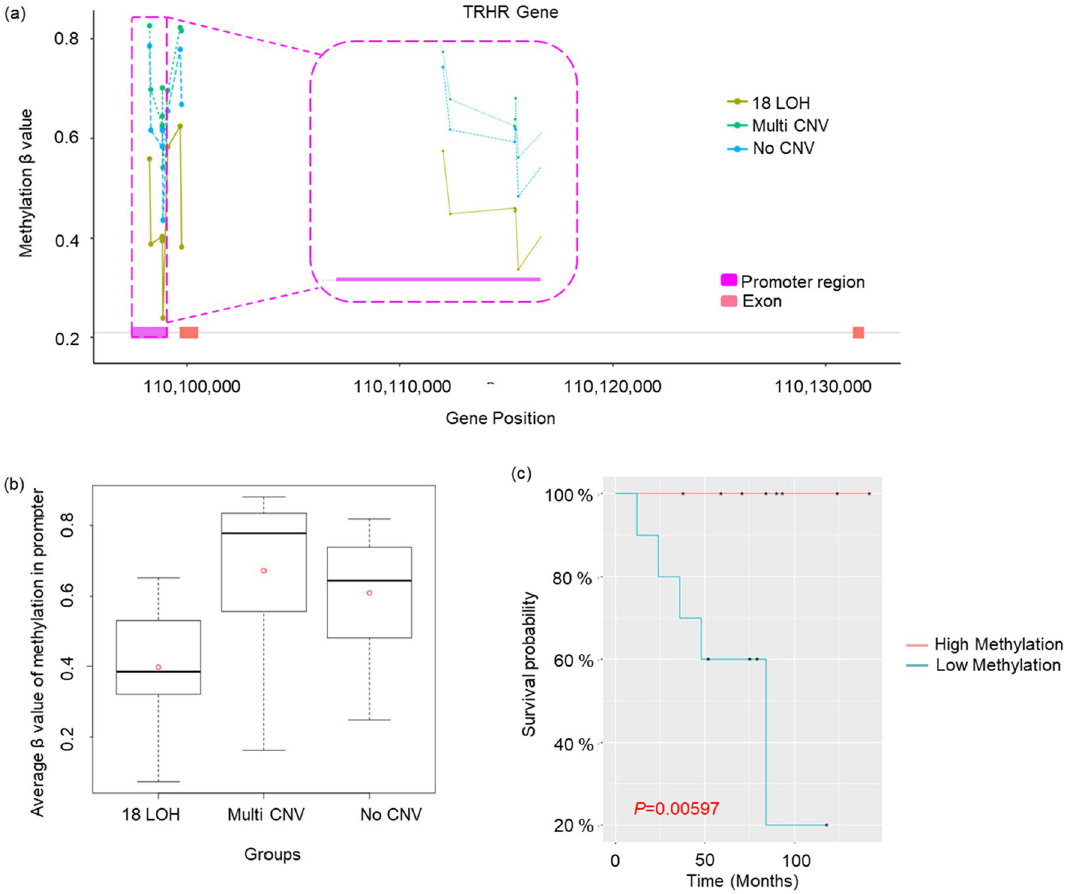
Figure 4. Methylation status of TRHR gene promoter. ( a ) A plot of beta-values of methylation probes within the promoter (Y-axis) and genomic coordinates (X-axis). The promoter region (pink), exon (orange) and intron are presented a bottom line of the graph. ( b ) A boxplot including distributions of average beta-value of methylation probes in the promoter for each molecular subtype. ( c ) Survival analysis comparing 18LOH tumors with high methylation (red line; samples 18LOH_2, _4, _5, _6, _7, _9, _14, _15, _16) and low methylation (blue line; samples 18LOH_1, _3, _8, _10, _11, _12, _13, _17, _18, _19) of TRHR